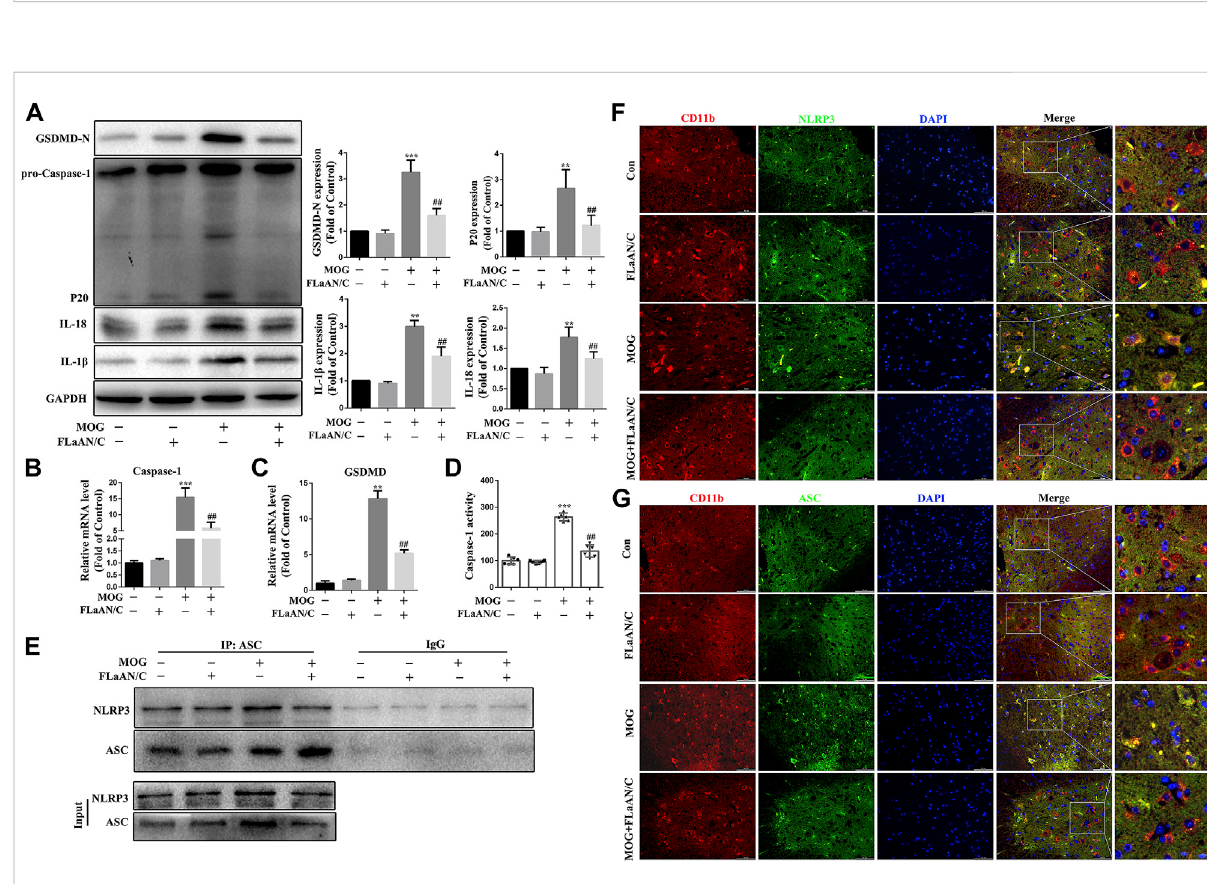
FIGURE 7 FLaAN/C attenuated NLRP3-mediated pyroptosis in EAE mice. (A) Abundance of caspase-1 p20, GSDMD-N, and IL-18 and IL-1 β proteins in mouse spinal cord. (B – C) The mRNA expression of Caspase-1 (B) and GSDMD (C) were quantitated by qRT-PCR. (D) Caspase-1 activity in mouse spinal cord was detected using the kit. (E) Detection of NLRP3 and ASC complex formation in spinal cord by co-immunoprecipitation. (F – G) Representative images ofNLRP3 + (F) andASC + (G) inCD11b + cells in sections of paraf fi n-embedded spinal cord tissue (scale bars:50 μ m). Data are shown as means ± SD (n = 6 per group). * p < 0.05, ** p < 0.01, *** p < 0.001; # p < 0.05, ## p < 0.01, ### p < 0.001. * vs. Control group; # vs. MOG